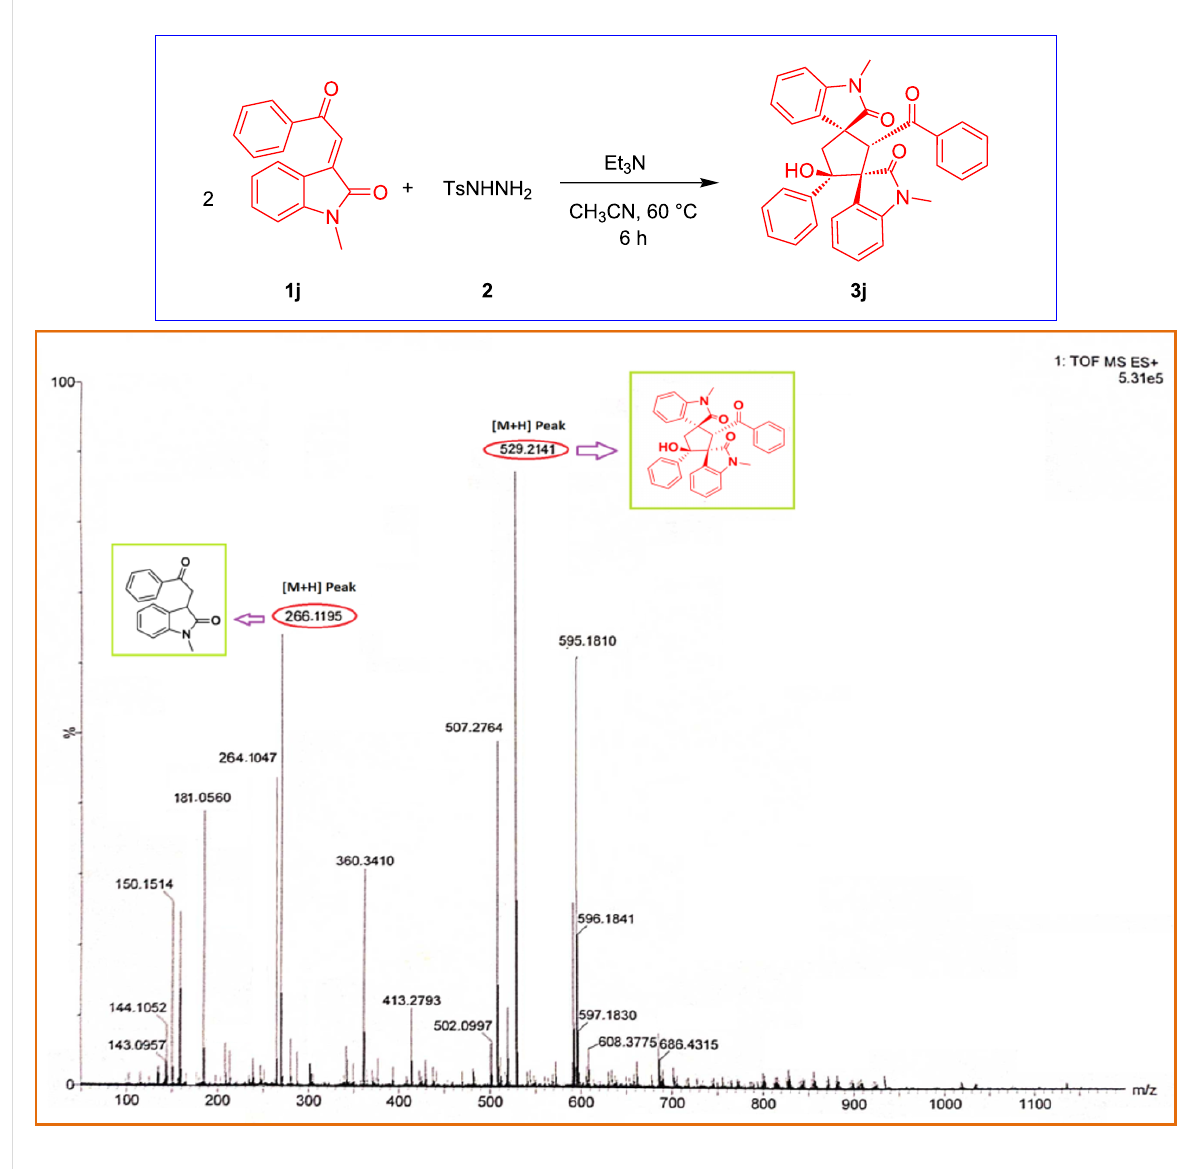
Figure 4: HRMS spectrum of the crude reaction mixture after 1 hour of the reaction.